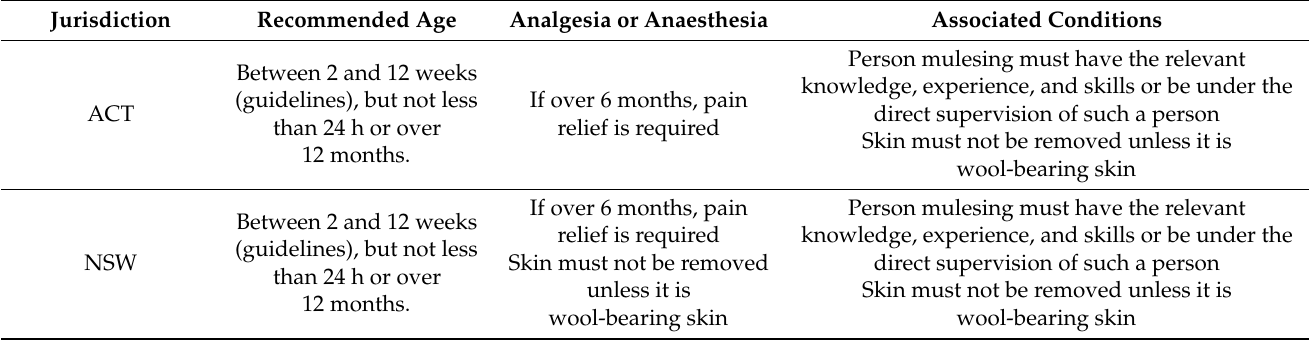
Table 4. Recommended age and requirement for analgesia or anaesthetic during mulesing procedure for each